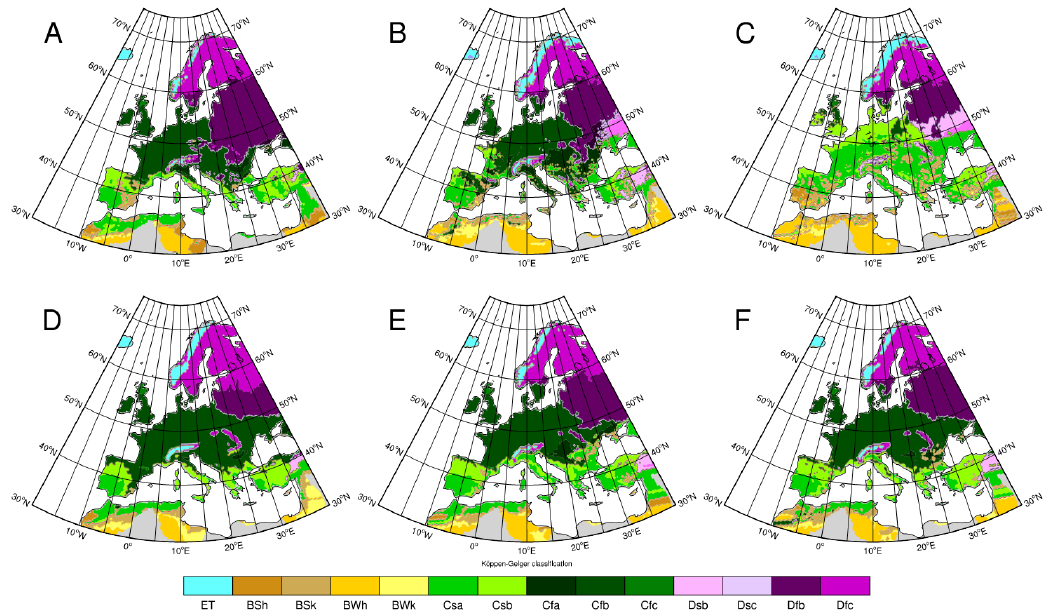
Figure 2. Simulated K-G climate classification according to E-OBS ( A ) and in ALADIN ( B ), HIRHAM ( C ), RegCM ( D ), RAMCMO2 ( E ) and RCA ( F ) without bias correction.